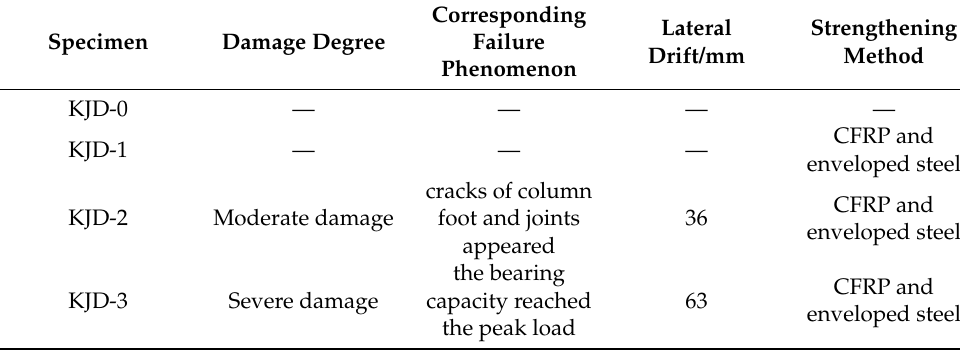
Table 3. Pre-damage and reinforcement method of